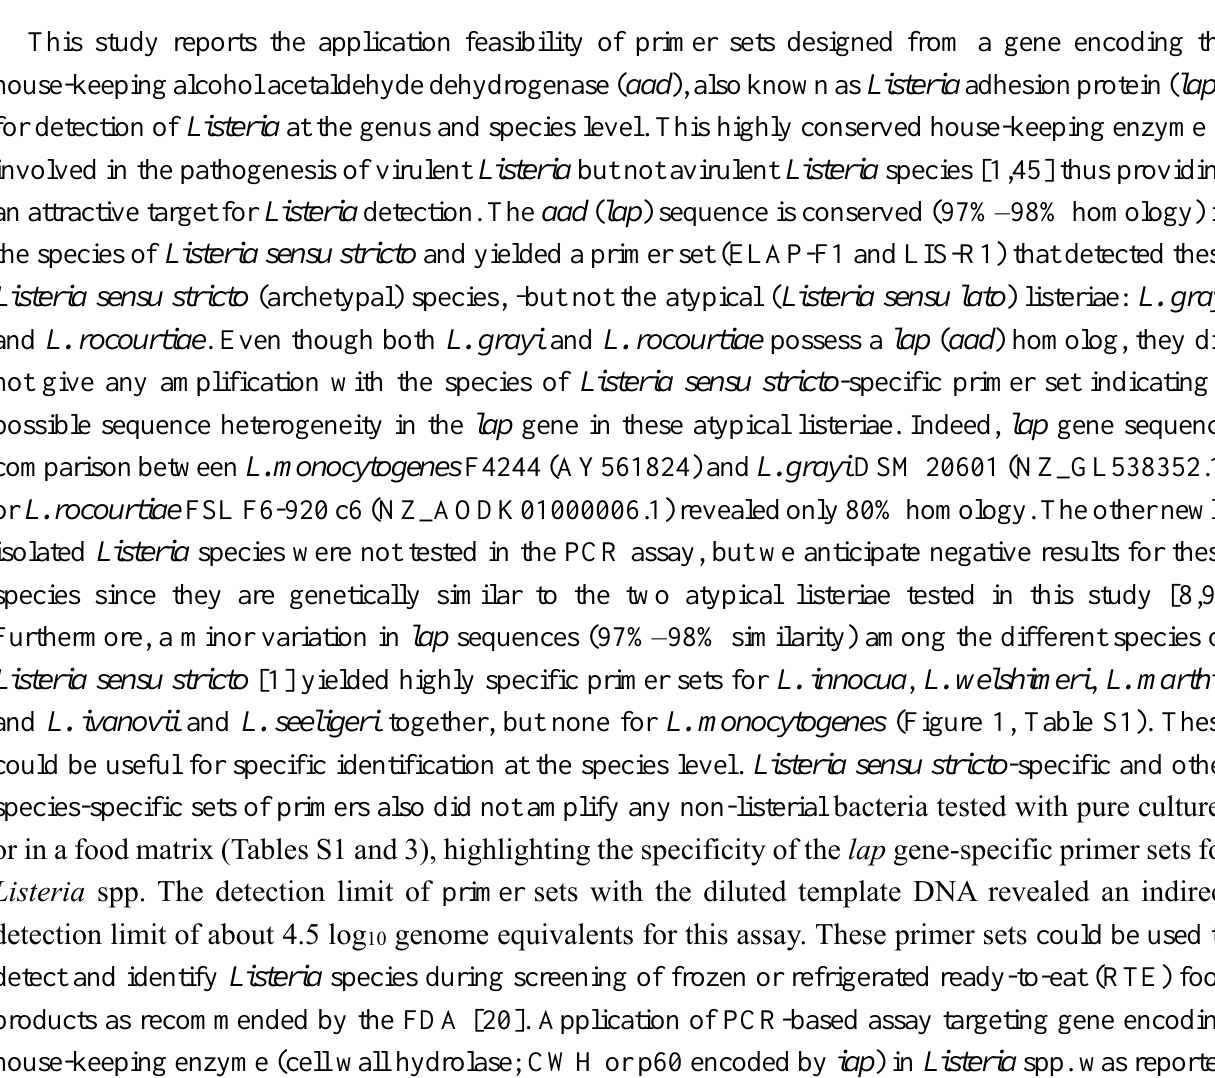
Table 3. Listeria detection using lap gene-specific primers in food systems. Inoculation Enrichment Time (h) in Treatment a (CFU/25g) Fraser Broth at 37 °C Uninoculated 0